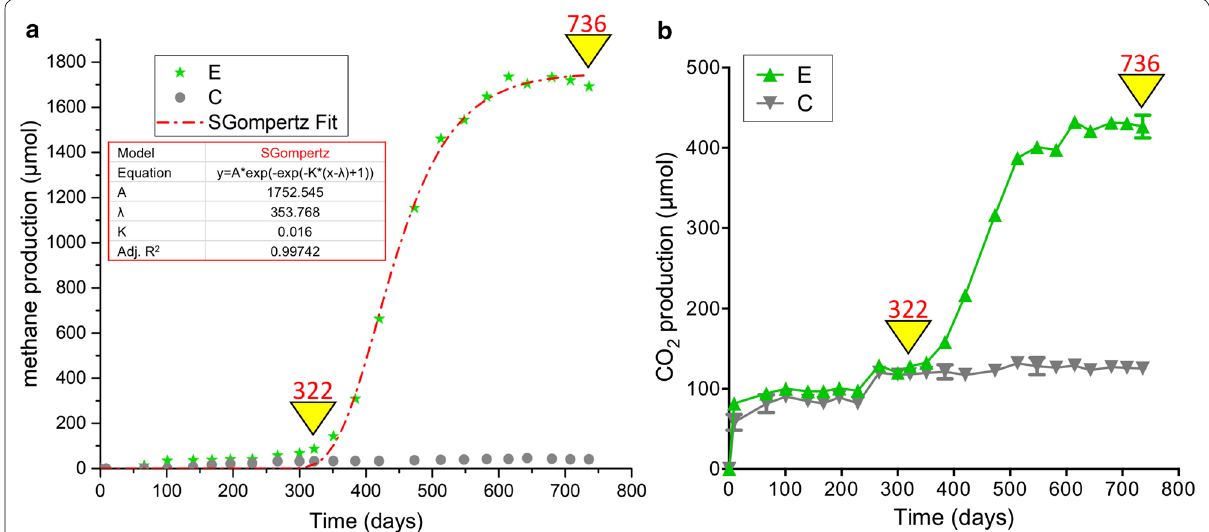
Fig. 1 Accumulative production of CH 4 ( a ) and CO 2 ( b ) in enrichment cultures amended with long‑chain n ‑alkanes (E) and control cultures without alkanes (C) inoculated with production water during 736‑day incubation and the predicted curve of methane production (red line in a ) with kinetic parameters using the modified Gompertz